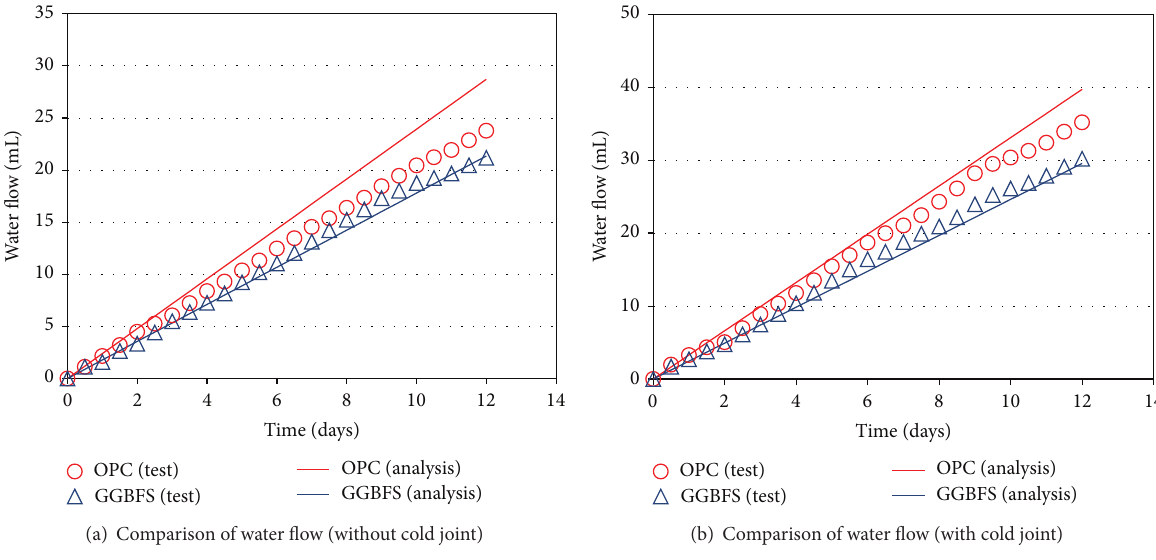
Figure 14: Comparison of cumulative water flow.